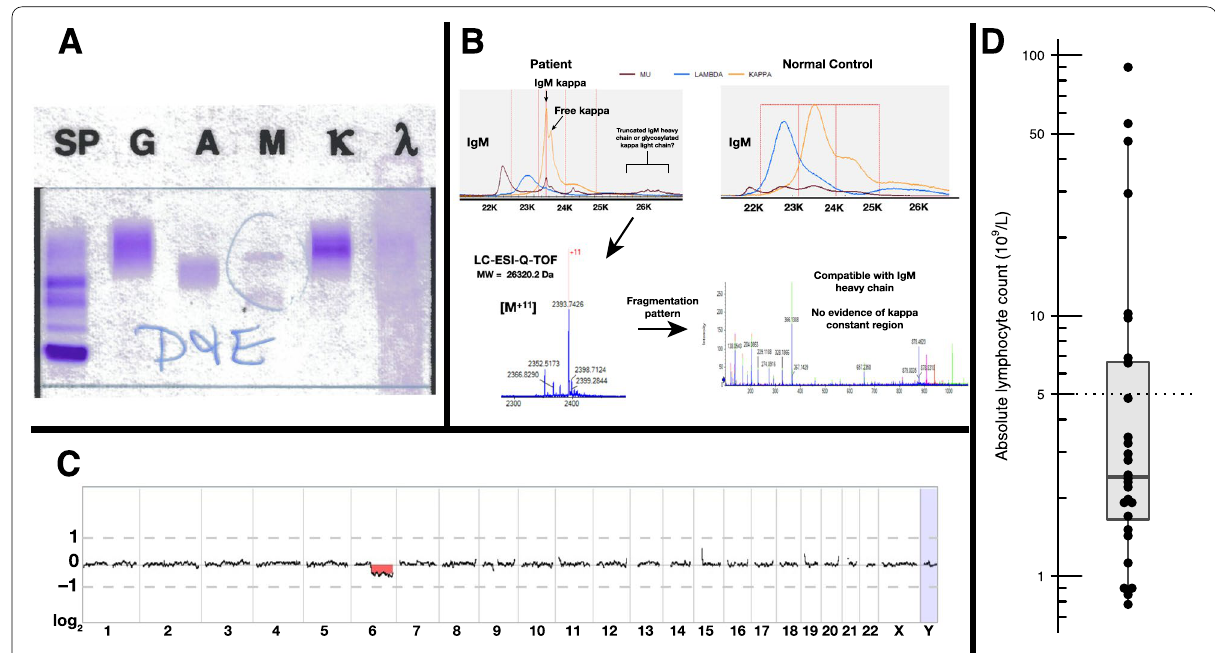
Fig. 2 Serum protein and genetic characterization of the case and lymphocyte counts in reported cases of mu heavy chain disease. A Serum immunoelectrophoresis identified a monoclonal protein composed of kappa light chains with a possible faint band at IgM. B The serum immunoglobulin-enriched matrix-assisted laser desorption ionization time-of-flight mass spectrometry (MASS-FIX) and monoclonal immunoglobulin rapid accurate mass measurement IgM spectra for the patient demonstrating a 26,320 Da fragment of IgM heavy chain. Upper left panel: MASS-FIX IgM spectra demonstrating 3 M-proteins (An IgM kappa plus free kappa plus a suspected IgM heavy chain). Upper right panel: MASS-FIX IgM spectra for a healthy donor. Lower left panel: An LC-ESI-Q-TOF of the suspected IgM fragment for the 11 charge state. Lower right + panel: Fragmentation spectra of the suspected IgM heavy chain, demonstrating a pattern consistent with an IgM heavy chain. C Array comparative genomic hybridization revealed a 6q deletion. D Absolute lymphocyte count of mu heavy chain disease cases previously reported in the literature and including this case, plotted on a log scale. Dashed line indicates 5 10 9 /L threshold for lymphocytosis. Abbreviations: LC-ESI-Q-TOF: liquid × chromatography coupled with electrospray ionization quadrupole time of flight mass